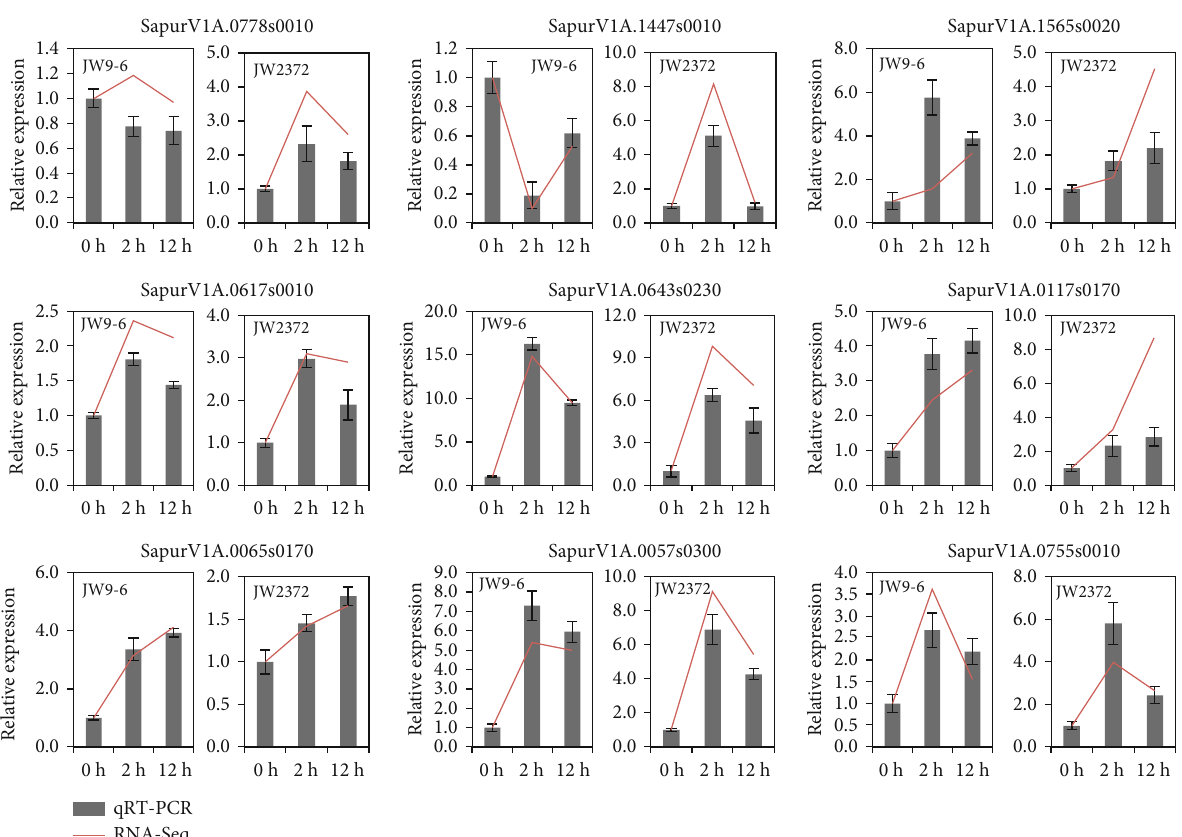
Figure 6: Validation of DEGs by qRT-PCR. The relative expression levels of ten randomly selected DEGs are veri fi ed by qRT-PCR. The expression levels at 0h are arbitrarily set to 1. Error bars represent the SD for three biological